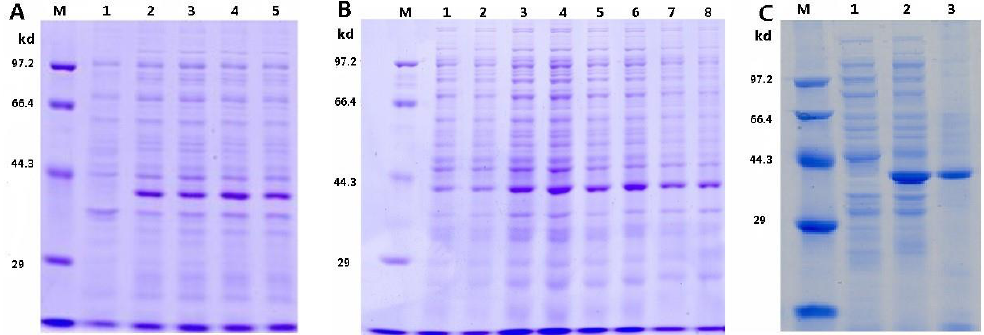
Figure 2. Expression of pTRX-srtA. ( A ) Effects of induce time on pTRX-srtA expression. M: Protein molecular mass standards; 1: Lysate of pTRX-srtA transfectant without induction; 2–5: Lysate of pTRX-srtA transfectant induced with 1.0 mmol/L IPTG at 37 ◦ C for 4 h, 5 h, 6 h and 7 h, respectively; ( B ) Effects of IPTG concentration and induction temperature on pTRX-srtA expression. M: Protein molecular mass standards; 1–4: Lysate of pTRX-srtA transfectant induced at 37 ◦ C for 6 h with different IPTG concentration of 0.25 mmol/L, 0.5 mmol/L, 1.0 mmol/L, and 2.0 mmol/L, respectively; 5–8: Lysate of pTRX-srtA transfectant induced with 1 mmol/L IPTG for 6 h, at the temperature of 22 ◦ C, 28 ◦ C, 37 ◦ C